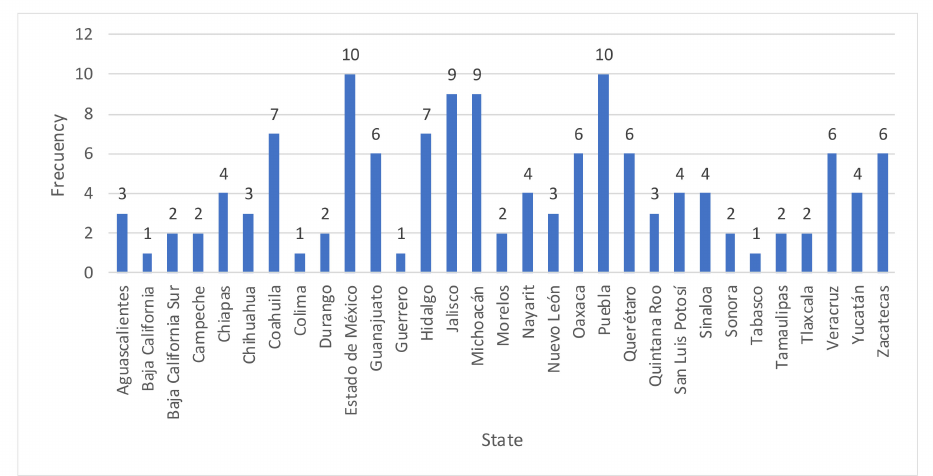
Figure 2. Number of Magic Towns by federal state. Source: own elaboration based on information available at www.datatur. sectur.gob.mx (accessed on 10 May